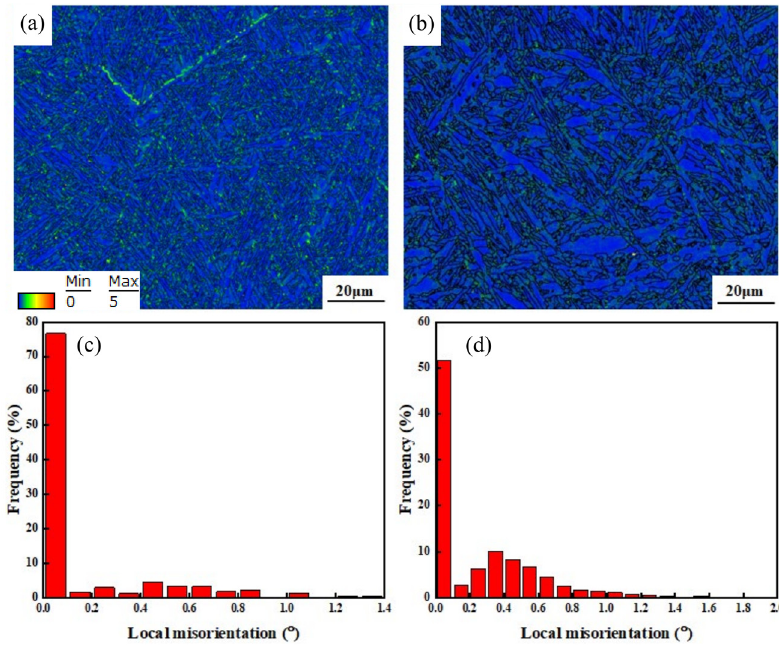
Figure 9. Comparison of local misorientation of the welding joints: ( a ) flux-cored wire welding joint; ( b ) cable wire welding joint; ( c , d ) statistical histogram for flux-cored wire and cable wire welding joints.